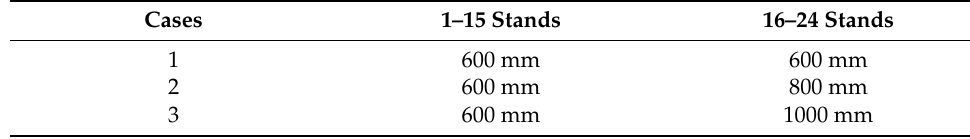
Figure 11. Longitudinal strain of strip in 3 inter −distance conditions . We selected the node at the bend after unloading, and the variation in the displace- ment in the x – direction is shown in Figure 12a. The small arc length represents the front of the strip. The value of X displacement at the front of the sheet is larger than the end in Figure 12a. The reason is the large deformation that occurs when the front of the sheet touches the rolls. In practice, the front of the strip is usually cut off due to continuous forming. The fluctuations in the lateral deflection flatten out slightly as the distance in- creases, because the increased distance allows for the more adequate release of the elastic stresses, making the forming more accurate. The results of the cross – sectional comparison between the unloaded sections and the target profile are shown in Figure 12b. The differ- ences are mainly on the deeper left side. The increased distance results in a slight reduc- tion in the forming accuracy of the enlargement. The reason is the increased lateral move- ment because of the excessive distance. Therefore, the distance needs to be combined with the actual conditions and has a certain range, while considering the control of costs.